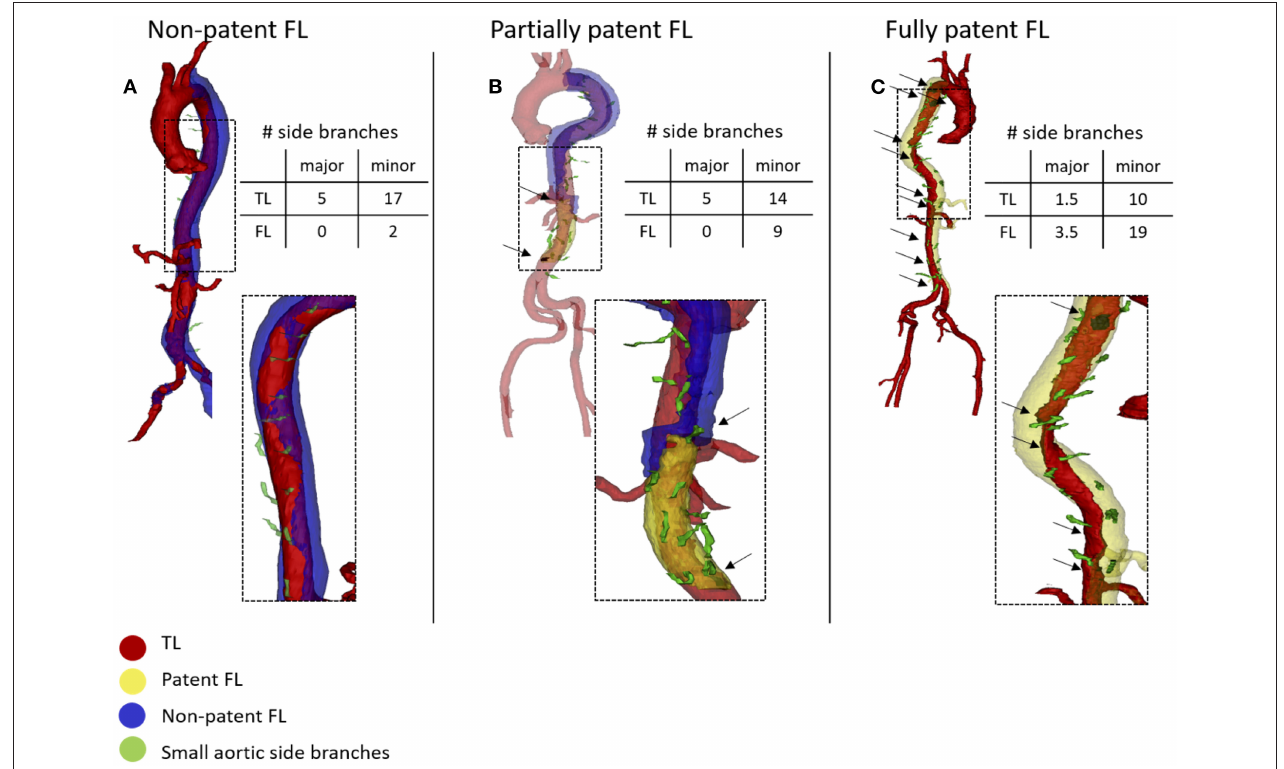
FIGURE 1 | 3D segmentation of three representative baseline Computed-tomography (CT)-scans. Black arrows indicate intimal tears. The false lumen (FL) is non-patent along its entire length (A) . Non-patent FL in the proximal segment, partially patent FL at the level of major visceral branches, fully patent FL in the distal segment (B) . Fully patent FL along its entire length (C) . Minor branches originate from the FL in fully patent segments of the FL, while they originate from the TL in non-patent segments of the FL (A) . In partially patent FL (B) minor branches originate from the FL in the patent segment and from the TL in the non-patent segment.